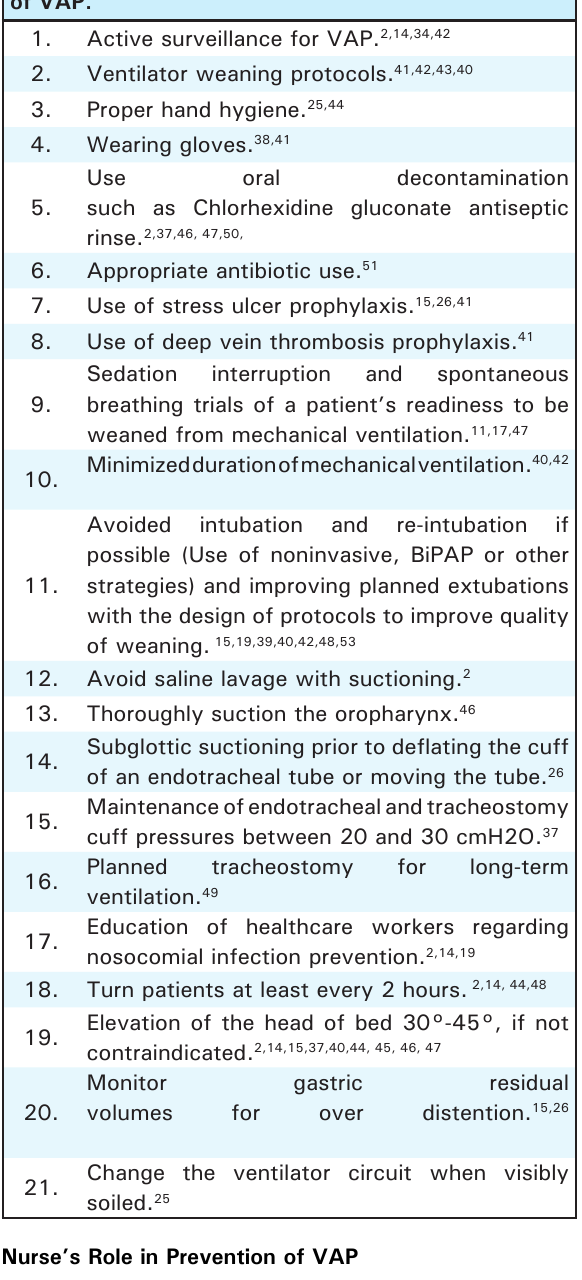
Table 1. Important bundle components for